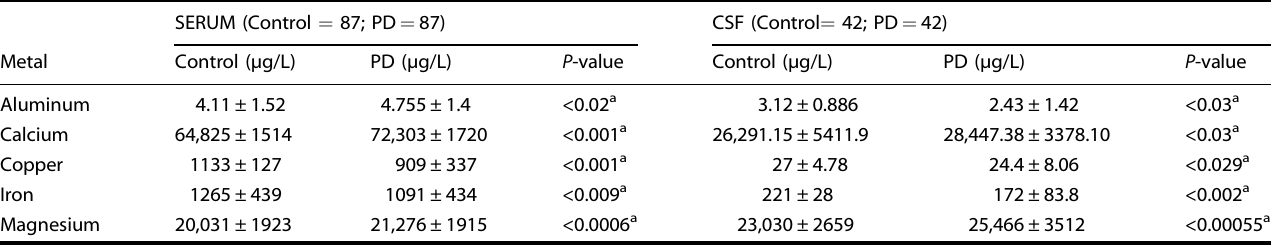
Table 1. Metal concentrations in serum and CSF determined using atomic absorption spectroscopy showing signi fi cant change in aluminum, calcium, copper, iron, and magnesium in PD compared to control. SERUM (Control = 87; PD =